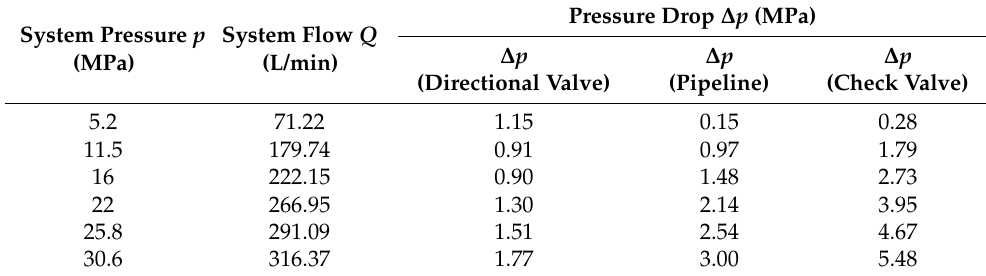
Table 5. Hydraulic cylinder retraction data under DN20 pipeline diameter.